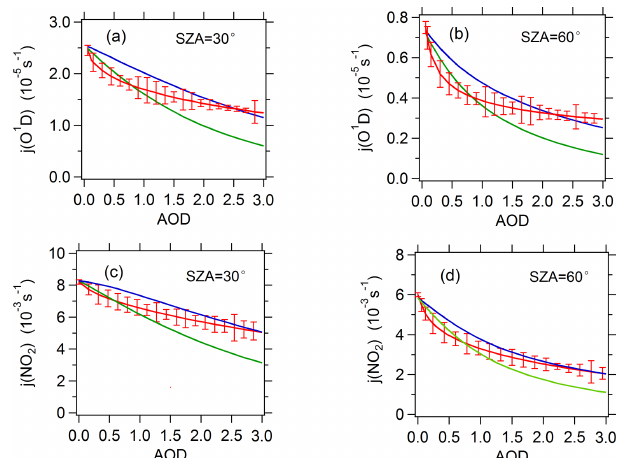
Figure 5. The relationship between observed or TUV-simulated photolysis frequencies and AOD (380nm) at SZAs of 30 and 60 ◦ . For j (O 1 D), a total ozone column classification of 330–360DU is chosen. The red line represents observed average photolysis fre- quencies; the blue line and green line represent TUV-simulated av- erage photolysis frequencies at SSAs of 0.95 and 0.85